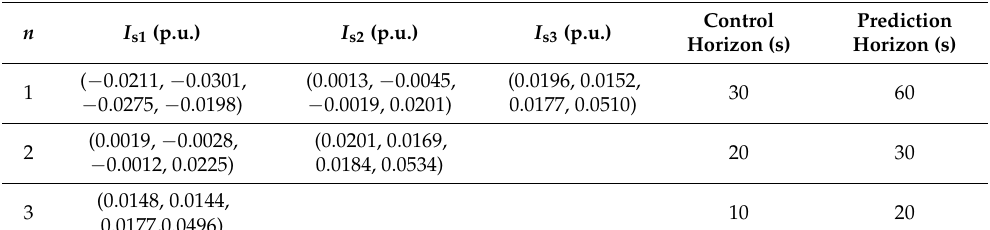
Table 4. The applicability judgment index I s m in case B.